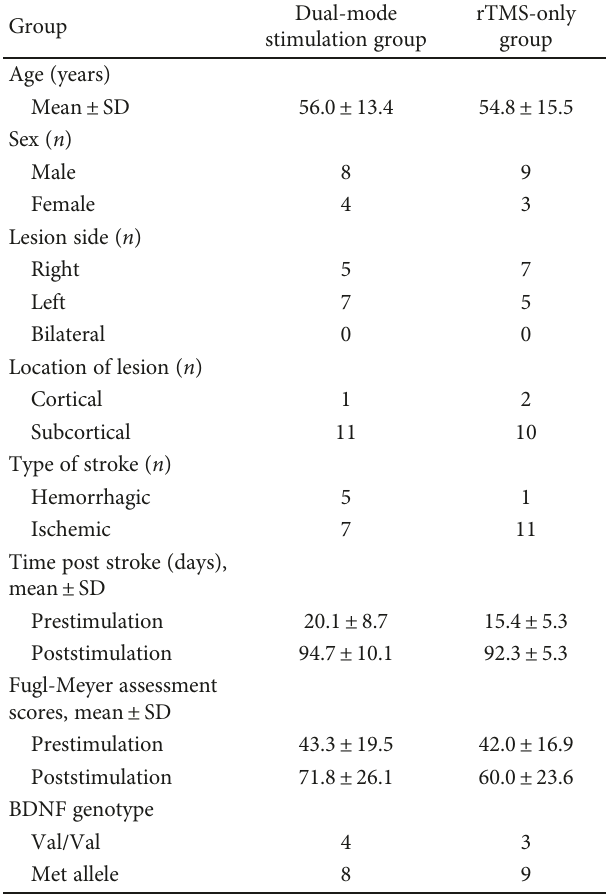
Table 1: Patient characteristics and motor